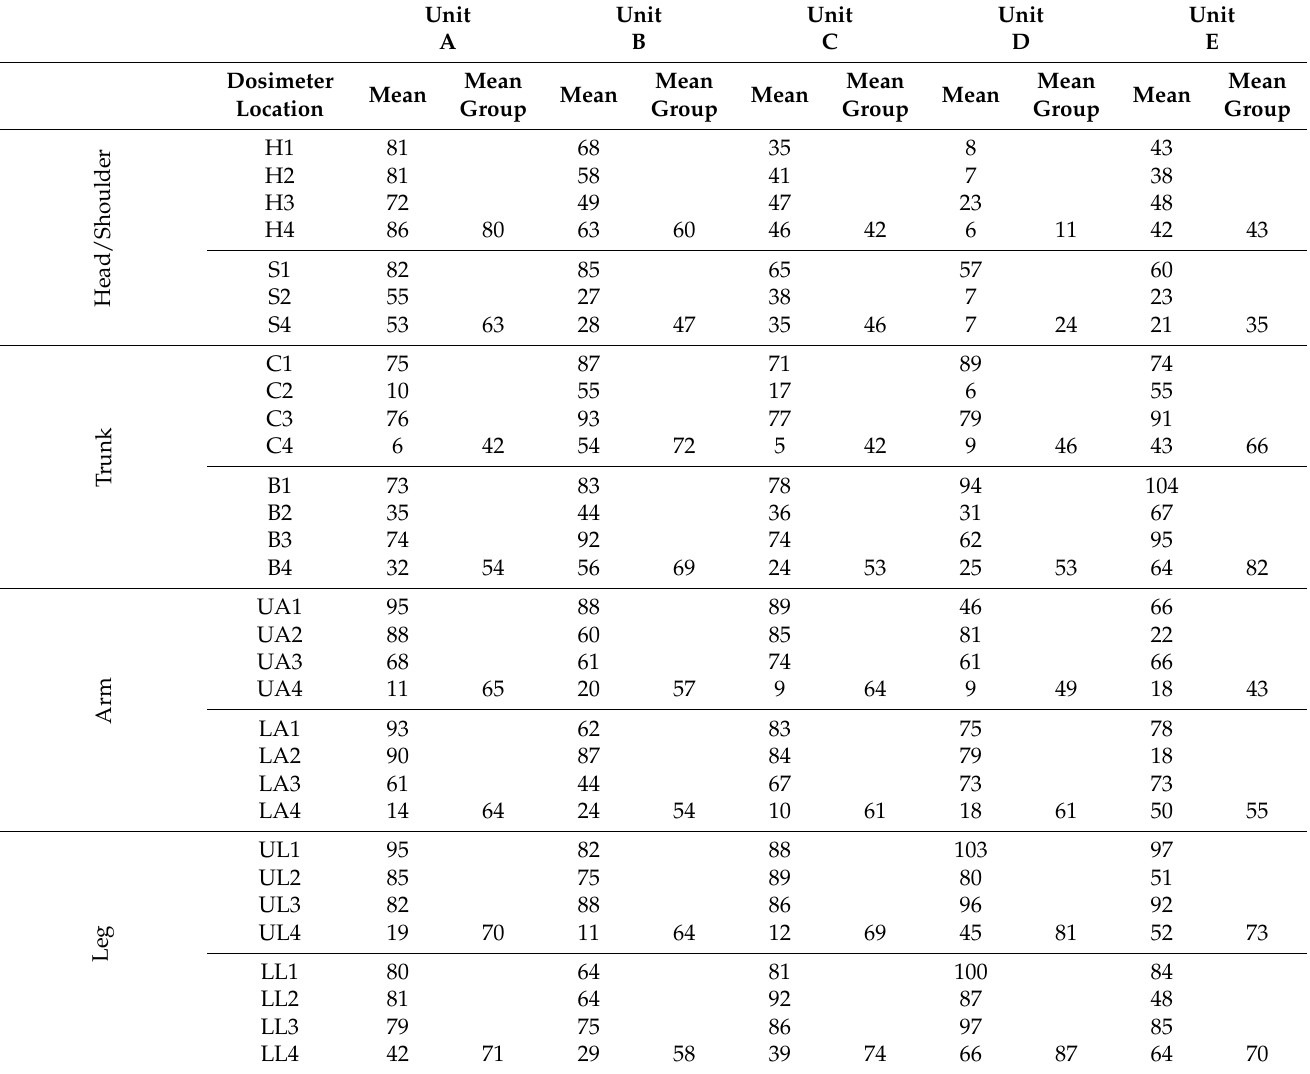
Table 3. Mean dosimeter readings for all participants combined in % of calibration irradiance. Values for 31 dosimeters on various body locations as measured in five different treatment units. Individual measurements of all participants are shown in Supplementary Material, Tables